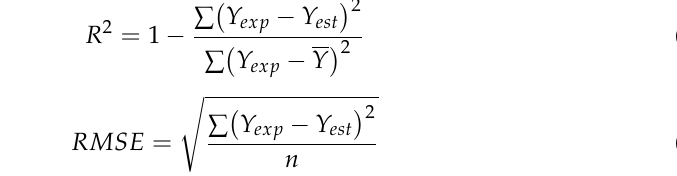
Figure 2. Measured soil temperature ( (cid:27) " = −0.05 m , (cid:27) (cid:22) = −0.15 m and (cid:27) ) = −0.25 m ); soil heat flux ( (cid:23) " = −0.10 m and (cid:23) (cid:22) = −0.20 m ); and soil water content ( (cid:3) " = −0.05 m and (cid:3) (cid:22) = −0.10 m ). The blue line represents half-hour data and the black line represents daily average data.